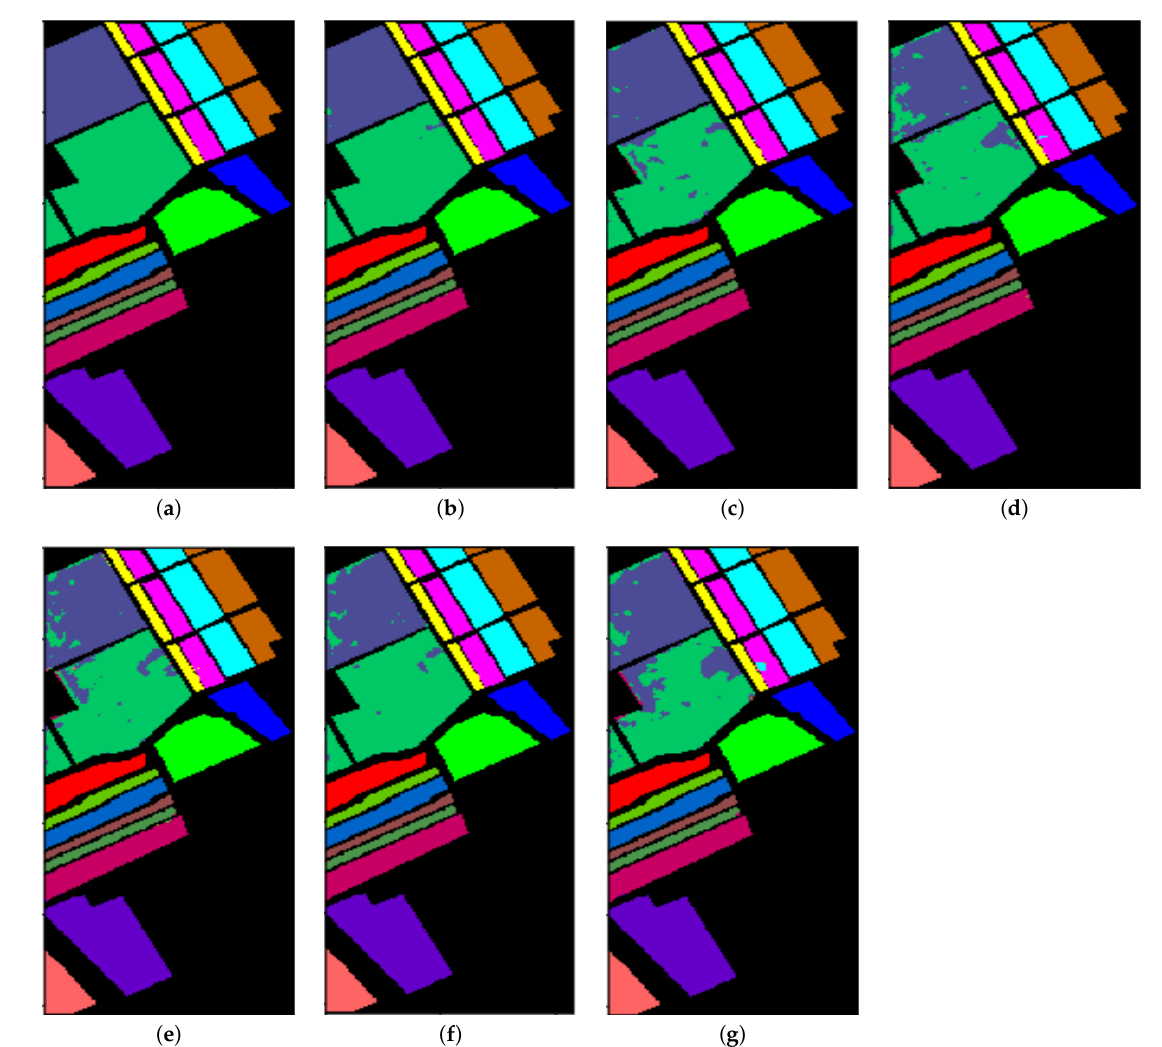
Figure 4. Classification maps of Salinas dataset for the proposed dual-branch spatial-spectral attention-based classification framework and methodologies used for comparison using 5% train- ing data. ( a ) Ground Truth; ( b ) SPAT-SPEC-HYP-ATTN (99.01%); ( c ) SPAT-HYP-ATTN (98.00%); ( d ) SPEC-HYP-ATTN (96.10%); ( e ) GAB-RP-S-3DCNN (97.24%); ( f ) SSAN (98.24%); ( g ) SVM- CK